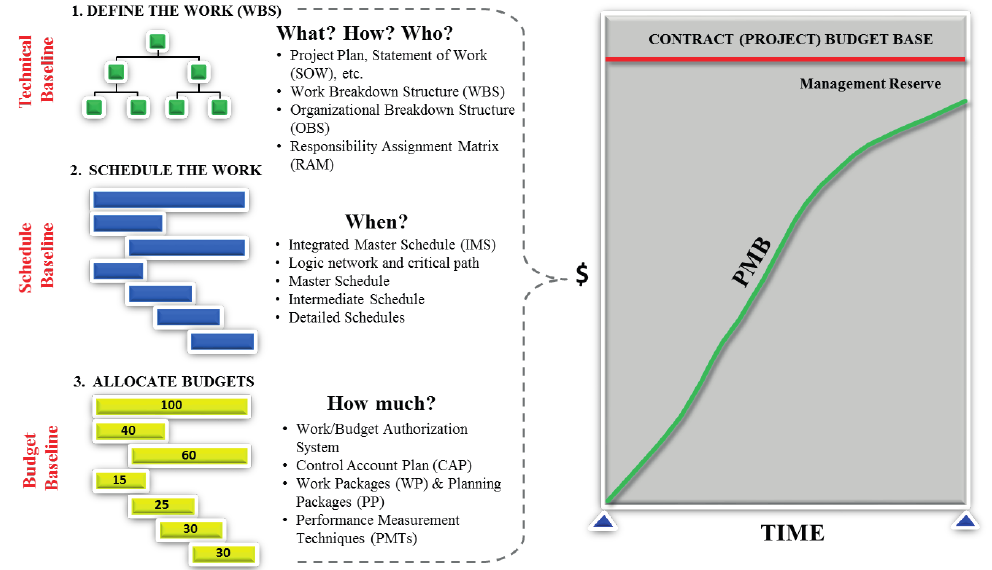
Fig. 6. WBS and the development of the Performance Measurement Baseline (NASA, 2018; GAO 09-3SP,